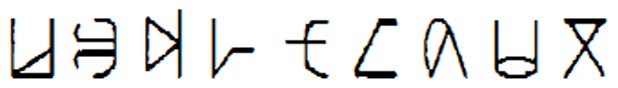
The nine Gibson figures.